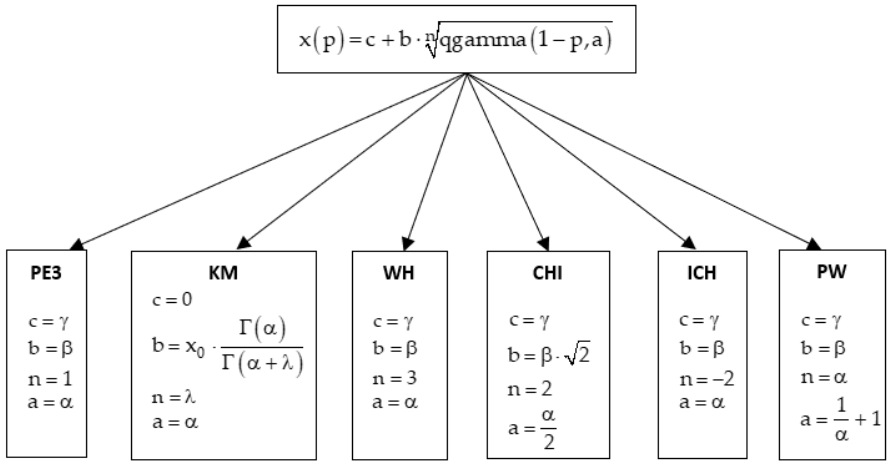
Figure 1. Cases of the inverse function for the analyzed gamma family distributions. Other particular forms of the inverse function are the distribution Pearson V (c = γ ; b = β ; n = − 1; a = α − 1) [18], four-parameter generalized extreme value (c = γ